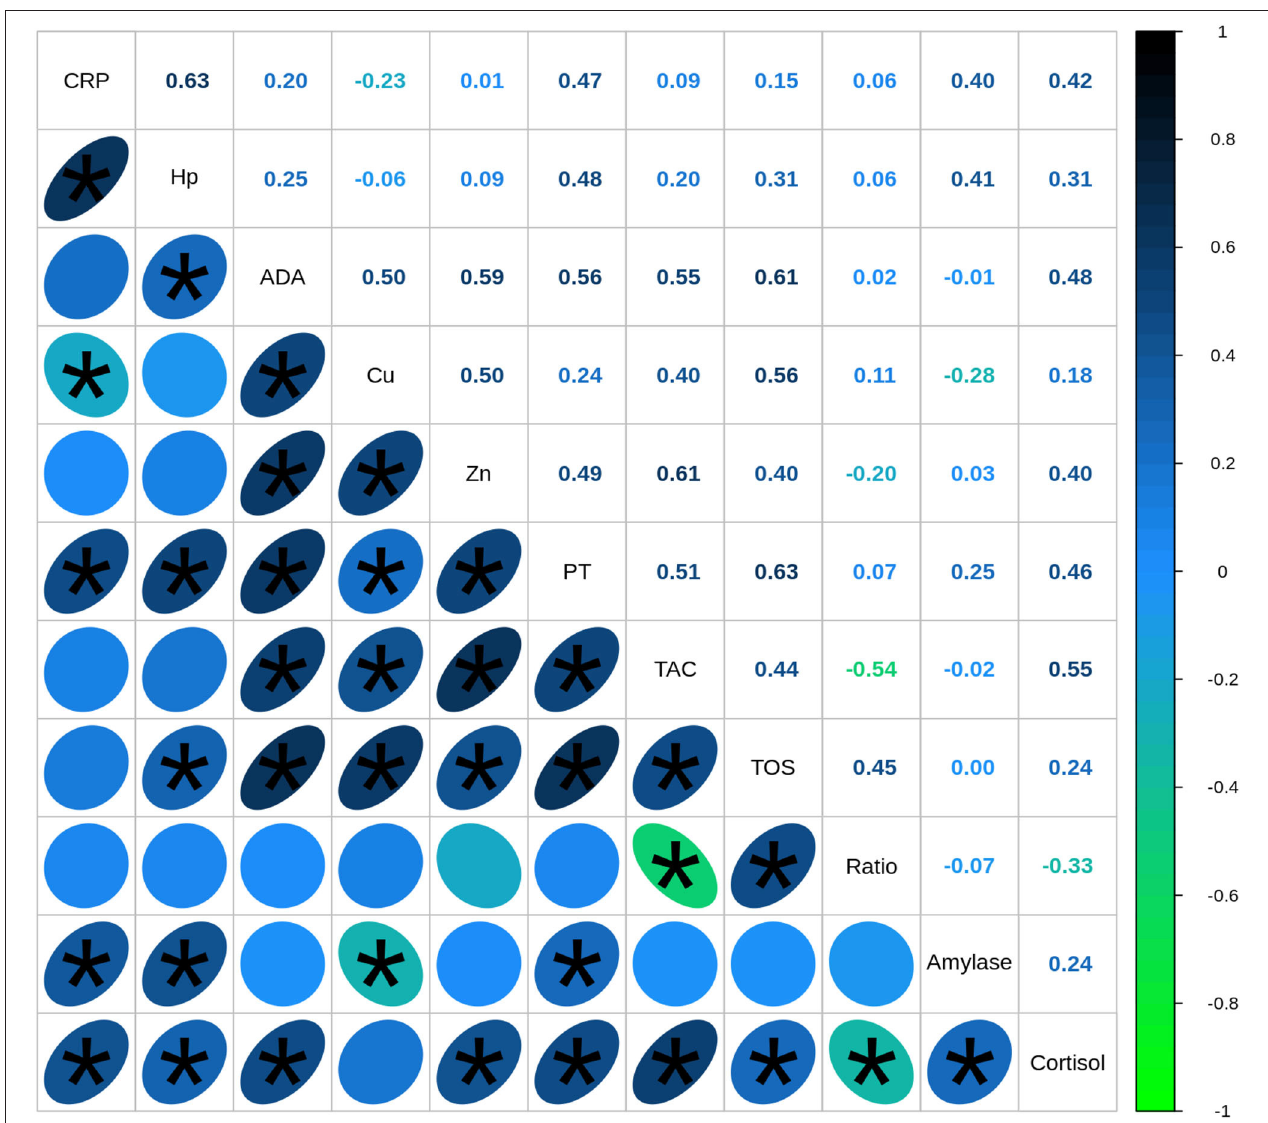
FIGURE 3 | Spearman’s correlation coefficients between biomarkers quantified in saliva of healthy ( n = 40) and diseased ( n = 67) pigs. CRP, C-reactive protein; Hp, haptoglobin; ADA, adenosine deaminase; TAC, total antioxidant capacity; TOS, total oxidant status; TP, total protein. Correlations with statistical significance are indicated by